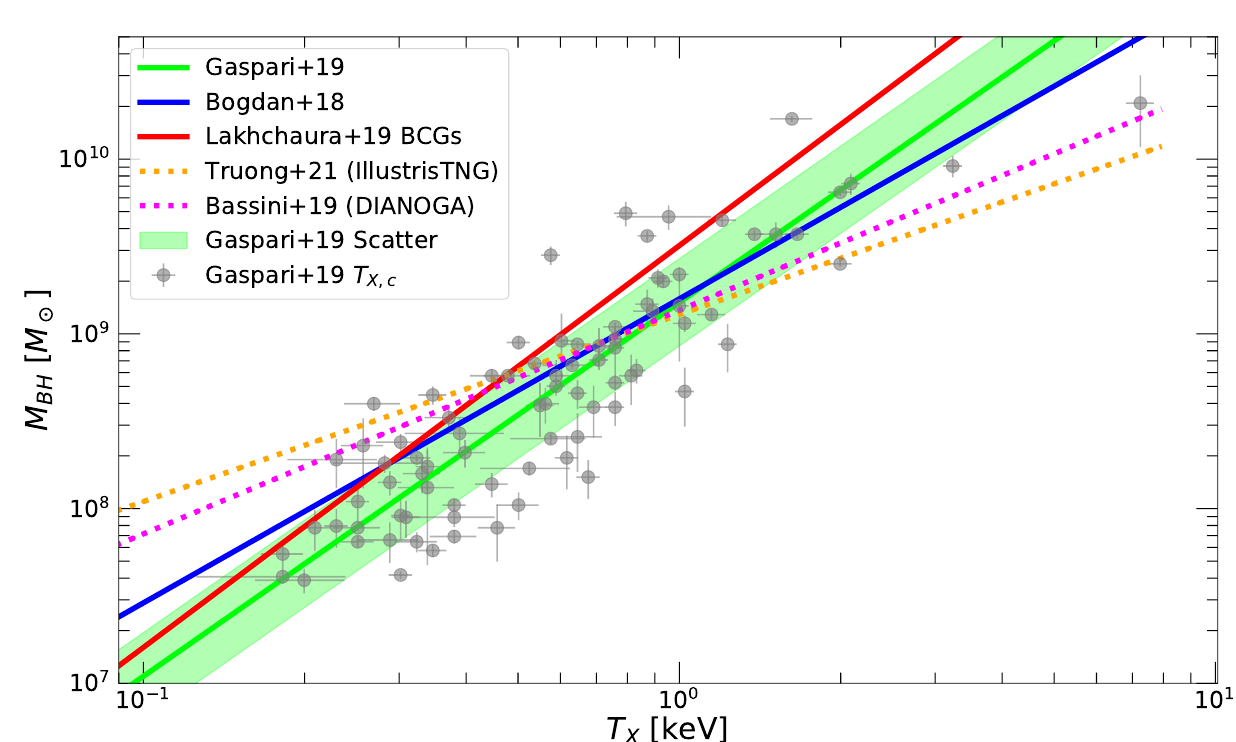
Figure 16. Relation between BH mass and IGrM X-ray temperature. The data points show dynamical measurements of BH mass plotted against the spectroscopic X-ray temperature of the host halo. The solid curves show the fitted observational relations from Gaspari et al. [77] (green; together with the quoted log-normal scatter), Bogdán et al. [76] (blue), and the “BCG” subsample of Lakhchaura et al. [78] (red). The dashed lines show the predictions of cosmological simulations with AGN feedback (Illustris TNG, Truong et al. [321]; DIANOGA, Bassini et al. [319]). The gray data points are taken from the sample of Gaspari et al. [77], which already included the smaller samples that were used by Bogdán et al. [76] and Lakhchaura et al.